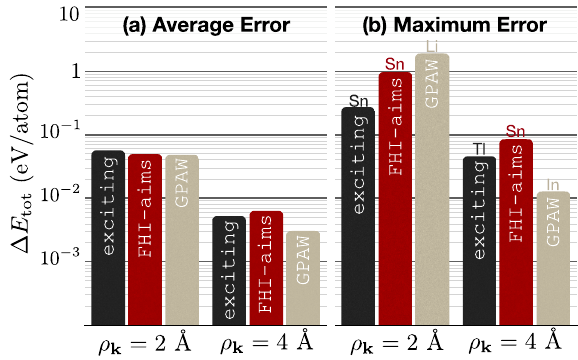
Fig. 2 Energy convergence with k-point density. Average ( a ) and maximum error ( b ) observed for the elemental solids are shown for two different k-point densities ρ k . The calculations were carried out for the elemental solids with exciting , FHI-aims , and GPAW using the PBE xc-functional. A simple summation with a Fermi- function smearing of 100 meV is used for the BZ integration to facilitate comparison between